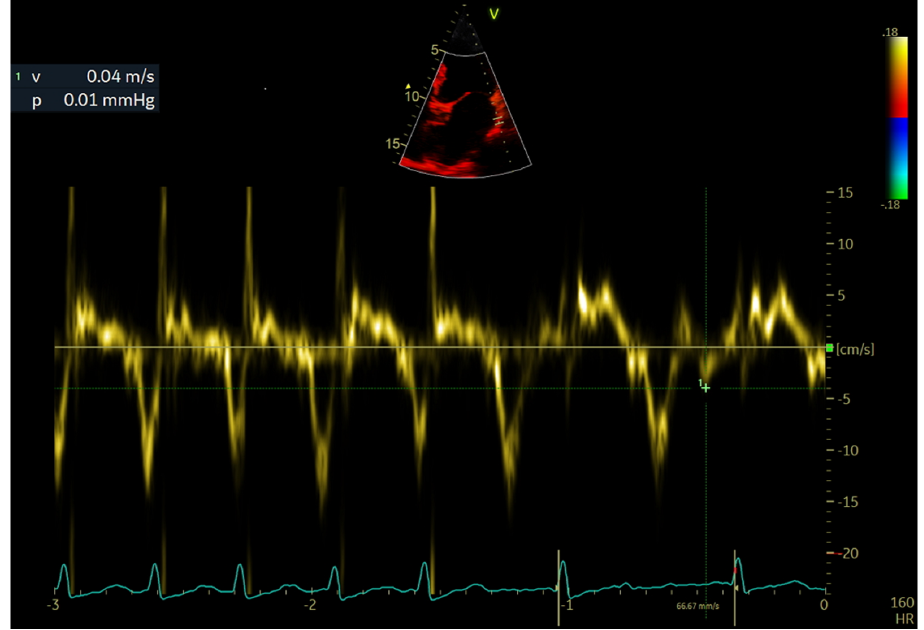
Figure 3. Left atrial wall motion velocity measurement during rapid atrial activity. Left atrial wall motion velocity measurement during a short pause in atrial activity. LAWMV of 4 cm/s from the